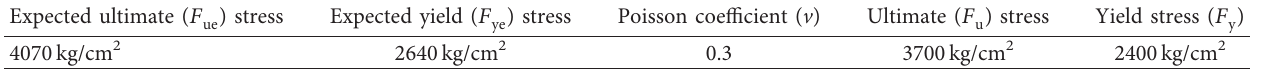
Table 1: Mechanical properties of steel.